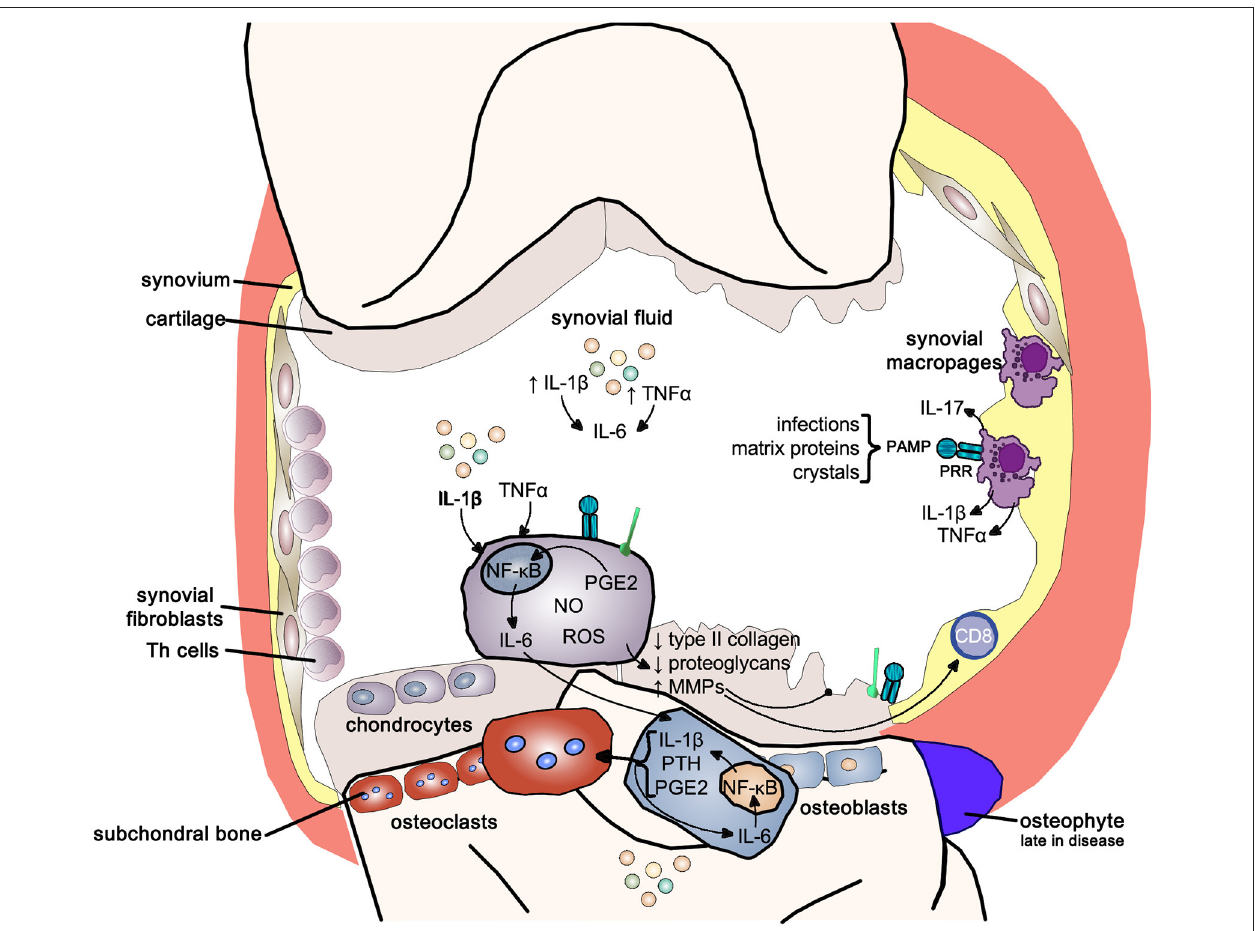
FIGURE 11 | Inflammatory pathways in osteoarthritis. Inflammatory pathways use the pro-inflammatory NF- κ B signaling pathway to drive the joint changes seen in osteoarthritis. NF- κ B, nuclear-factor kappa-light-chain-enhancer of activated B cells; IL-1b, interleukin 1 beta; IL-6, interleukin-6; TNF α , tumor necrosis factor alpha; IL-17, interleukin-17; PAMP, pathogen-associated molecular pattern; PRR, pattern-recognition receptor; PGE2, prostaglandin E2; NO, nitric oxide; ROS, reactive oxygen species; MMPs, matrix metalloproteases; PTH, parathyroid hormone.